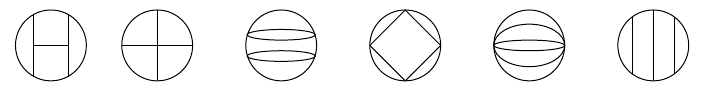
Figure 7 . Examples of diagrams expected to survive cancellations at four- and